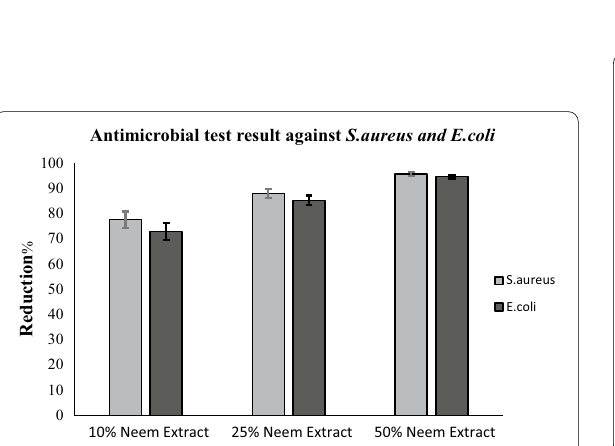
Fig. 6 Microbial reduction with the increment of neem extract